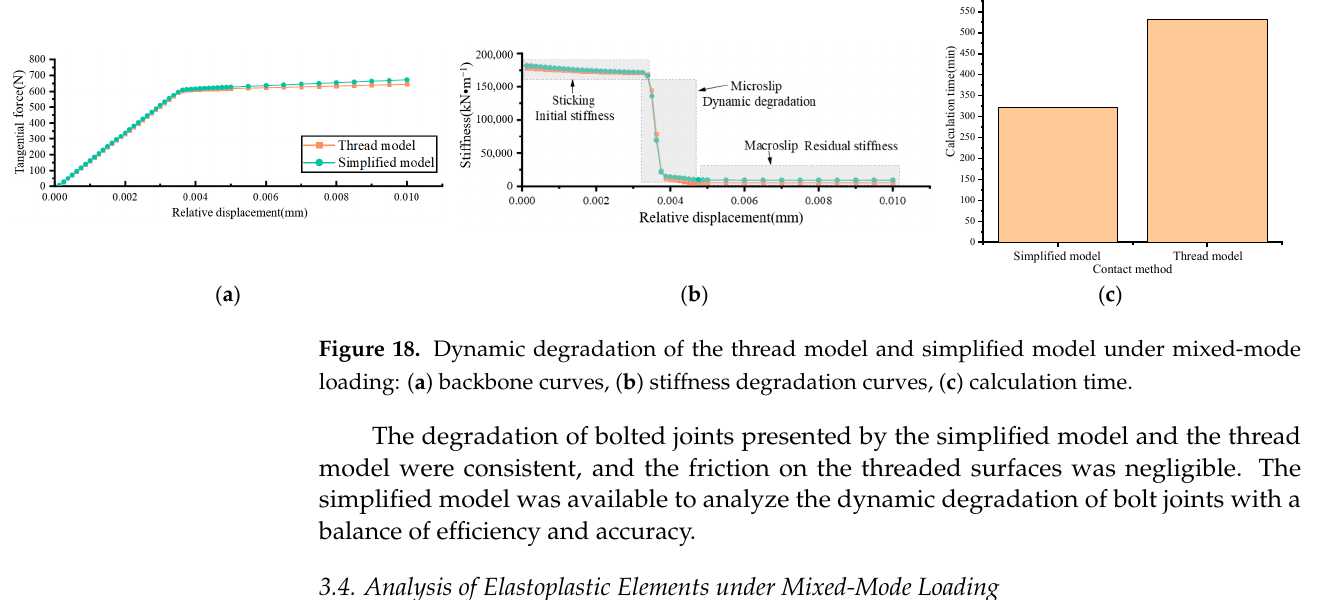
Figure 18. Dynamic degradation of the thread model and simplified model under mixed-mode loading: ( a ) backbone curves, ( b ) stiffness degradation curves, ( c ) calculation time. , while the tangential force T in